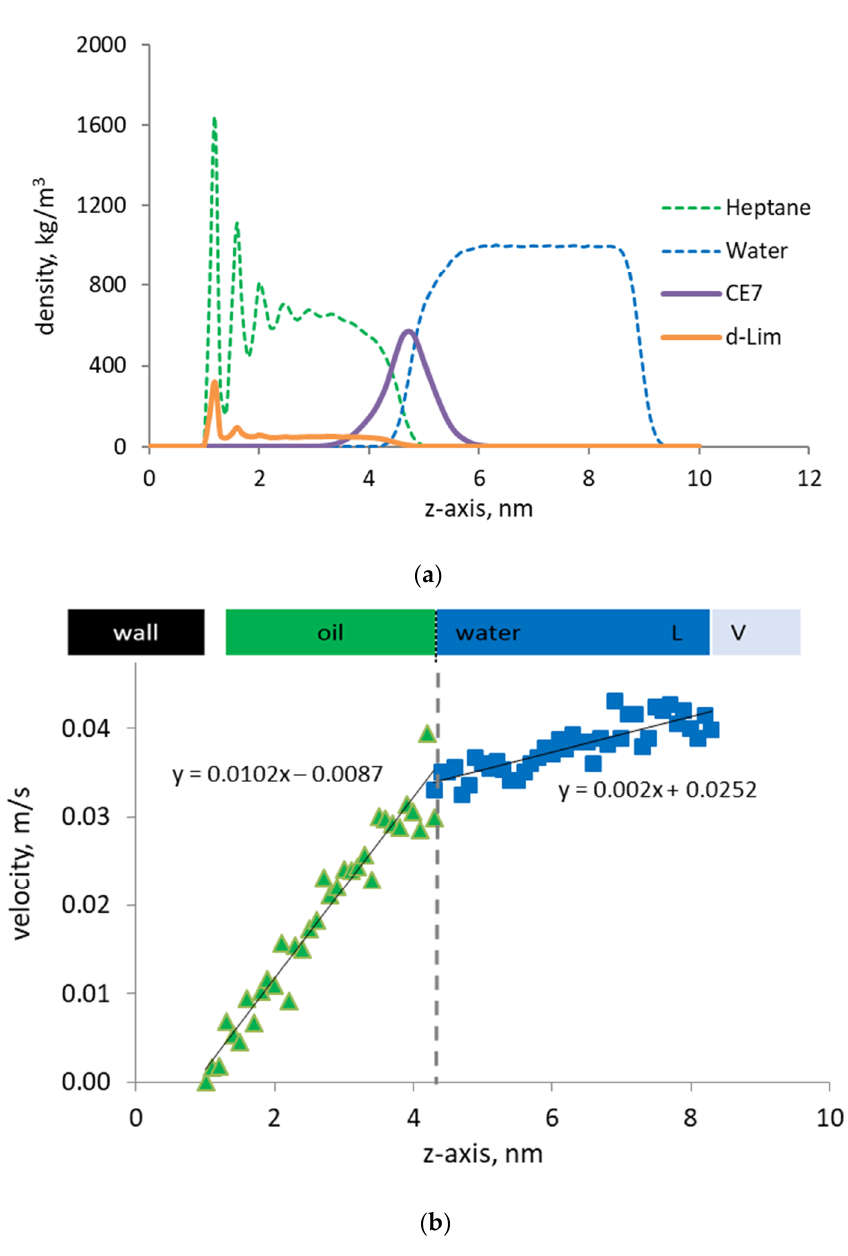
Figure 5. ( a ) Density profiles of n-heptane (green), water (blue) in the presence of surfactant (purple), and d-limonene solvent (orange) by the organic capillary wall; ( b ) Velocity profiles of water and oil phase by the organic capillary wall under steady-state Couette flow.